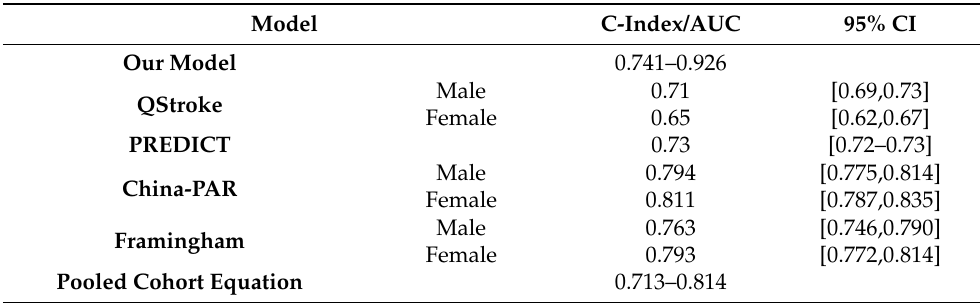
Table 5. Table of AUC/C-index values of five available models and our model. The 95% CI of C-index was also shown when available.